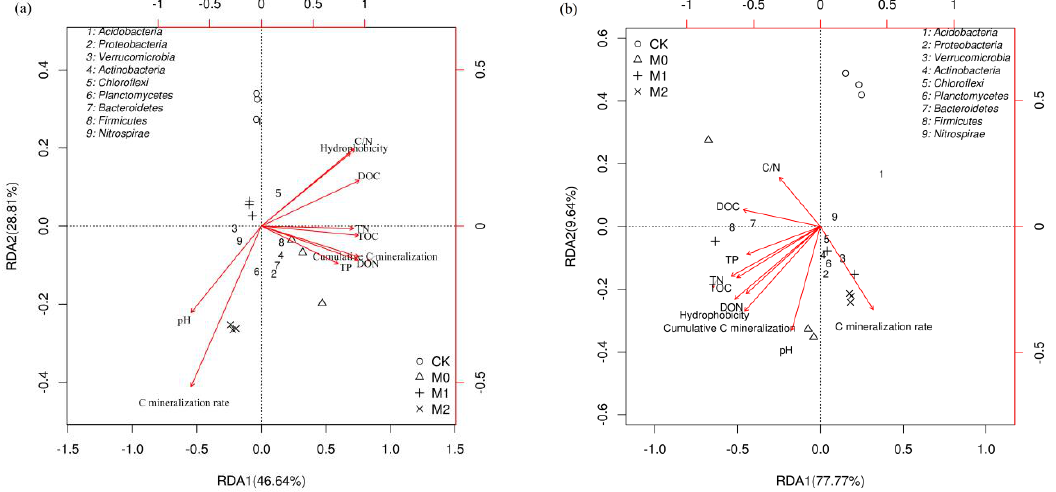
Figure 5. Redundancy analysis (RDA) of soil bacterial community compositions (phylum level) and soil characteristics for individual samples in topsoil ( a ) and subsoil ( b ) soil layer. pH: soil acidity; TOC: total organic carbon; TN: total nitrogen; TP: total phosphorus; DOC: dissolved organic carbon; DON: dissolved organic nitrogen; C/N: TOC to TN ratio.